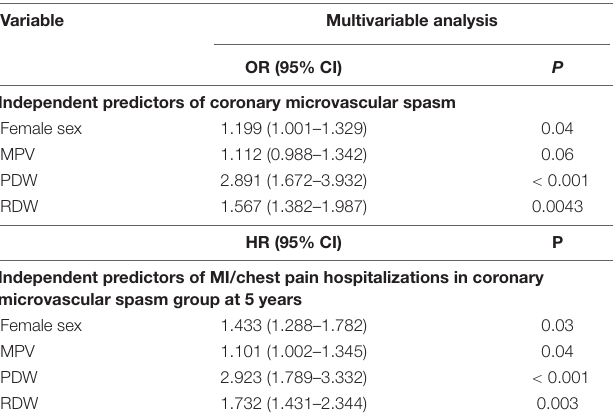
TABLE 3 | Independent predictors in multivariable logistic regression analysis and Cox regression analysis.